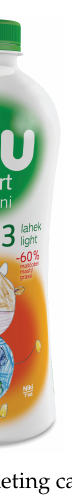
Figure 2. Example showing that child-targeted marketing can be also used for promotion of minimally processed foods: packaging of plain yoghurt with reduced